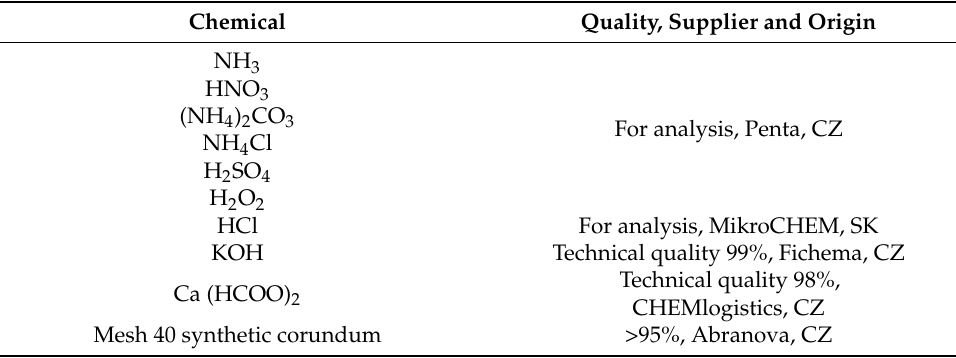
Table 2. Quality, supplier and origin of used chemicals.